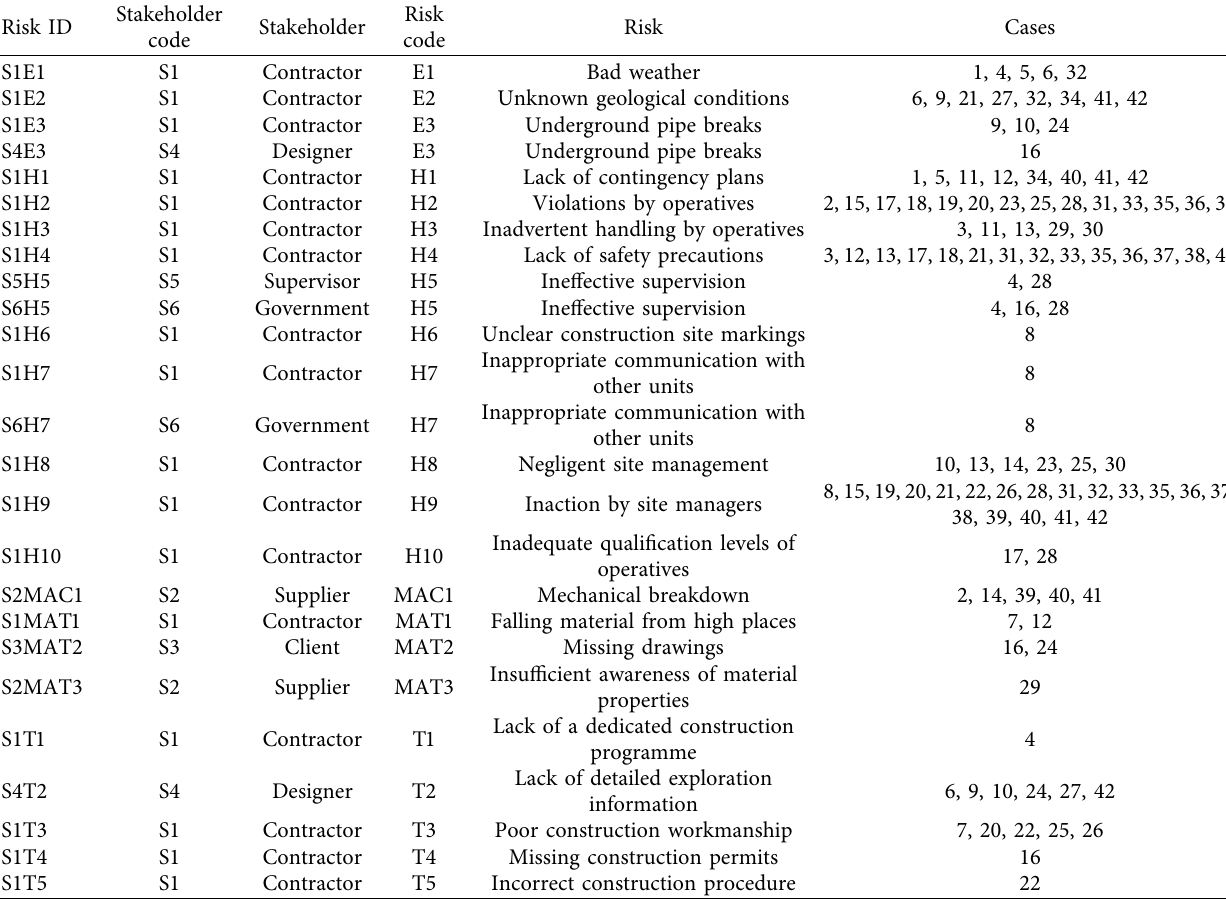
Table 6: Relationship between stakeholders and safety risk